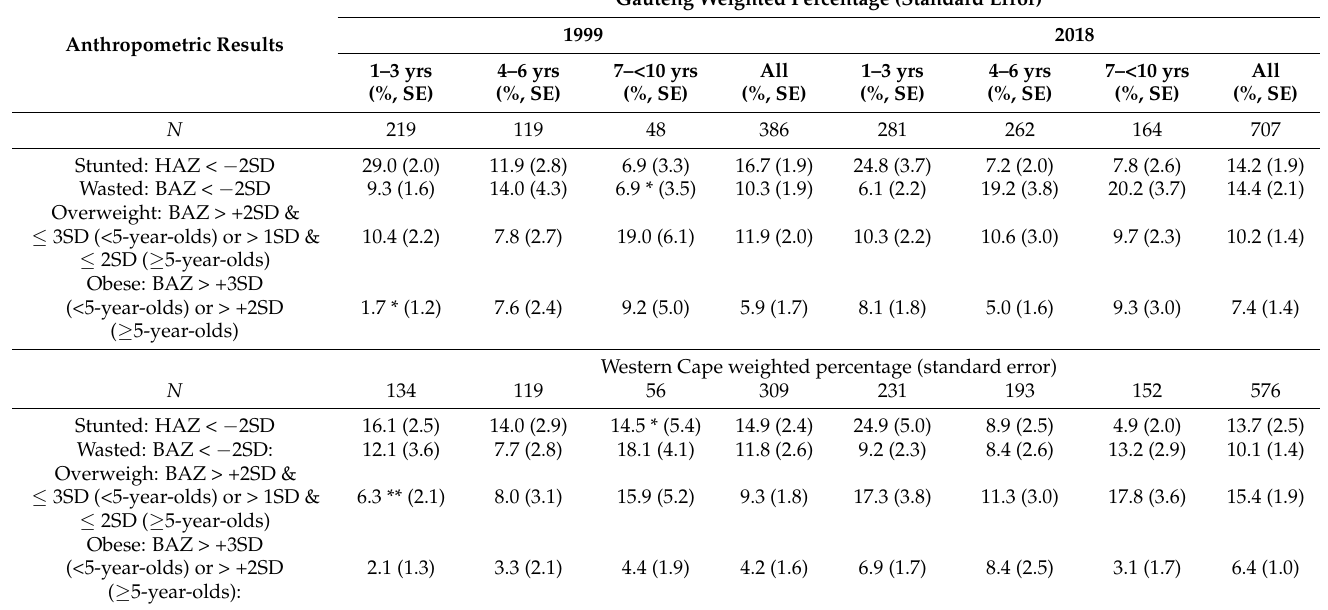
Table 7. Comparison of prevalence of stunting, wasting, overweight and obesity in 1–<10-year-old children between 1999 and 2018 by age group and overall, within Gauteng and the Western Cape in 1999 and 2018.